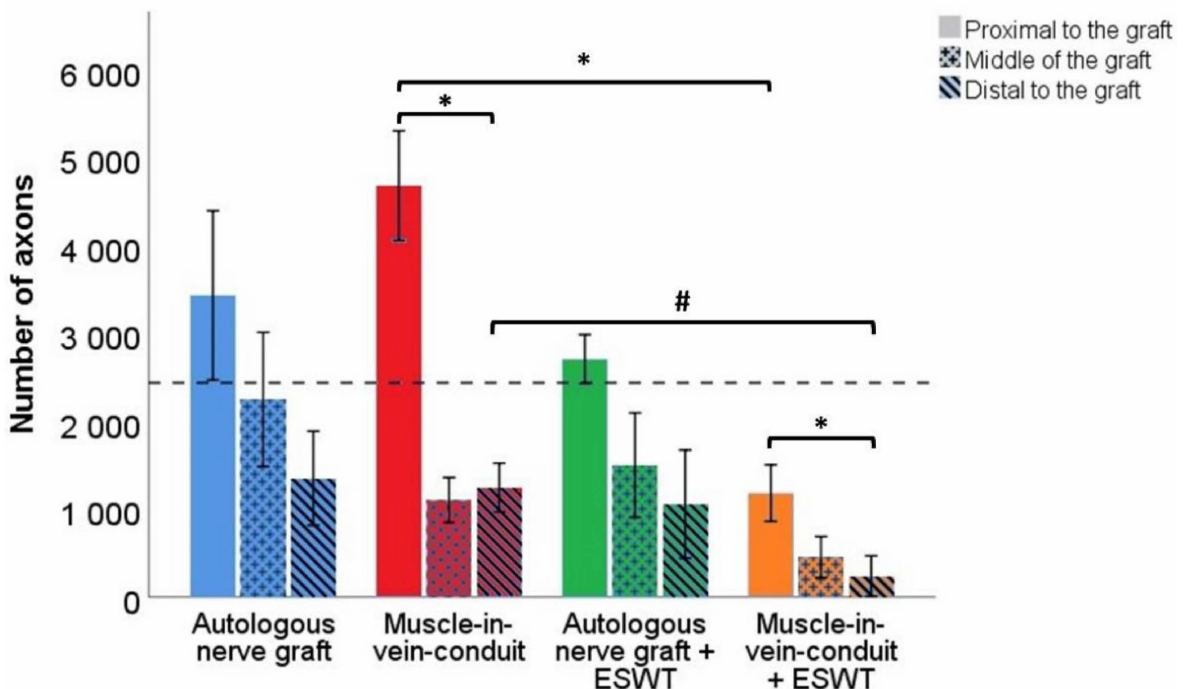
Figure 9. Number of axons in different segments of the reconstructed right median nerve 12 weeks following resection of a 7 mm segment of the right median nerve and immediate reconstruction with an autologous nerve graft ( n = 5), a muscle-in-vein conduit ( n = 6), an autologous nerve graft + ESWT (autologous nerve graft with postoperative extracorporeal shockwave therapy) ( n = 4) or a muscle- in-vein conduit + ESWT (muscle-in-vein conduit with postoperative extracorporeal shockwave therapy) ( n = 4). The dashed line indicates the number of axons in the uninjured median nerve at the mid-humerus level (2442 ± 19). Statistical evaluation was performed with the nonparametric Kruskal–Wallis test and the Dunn–Bonferroni post hoc test. For subgroup analysis of identical reconstructive approaches, the Mann–Whitney U test was used. Repeated measurements of the same group were compared by means of the nonparametric Friedman test. Note: * p < 0.05, # p < 0.05 in subgroup analysis